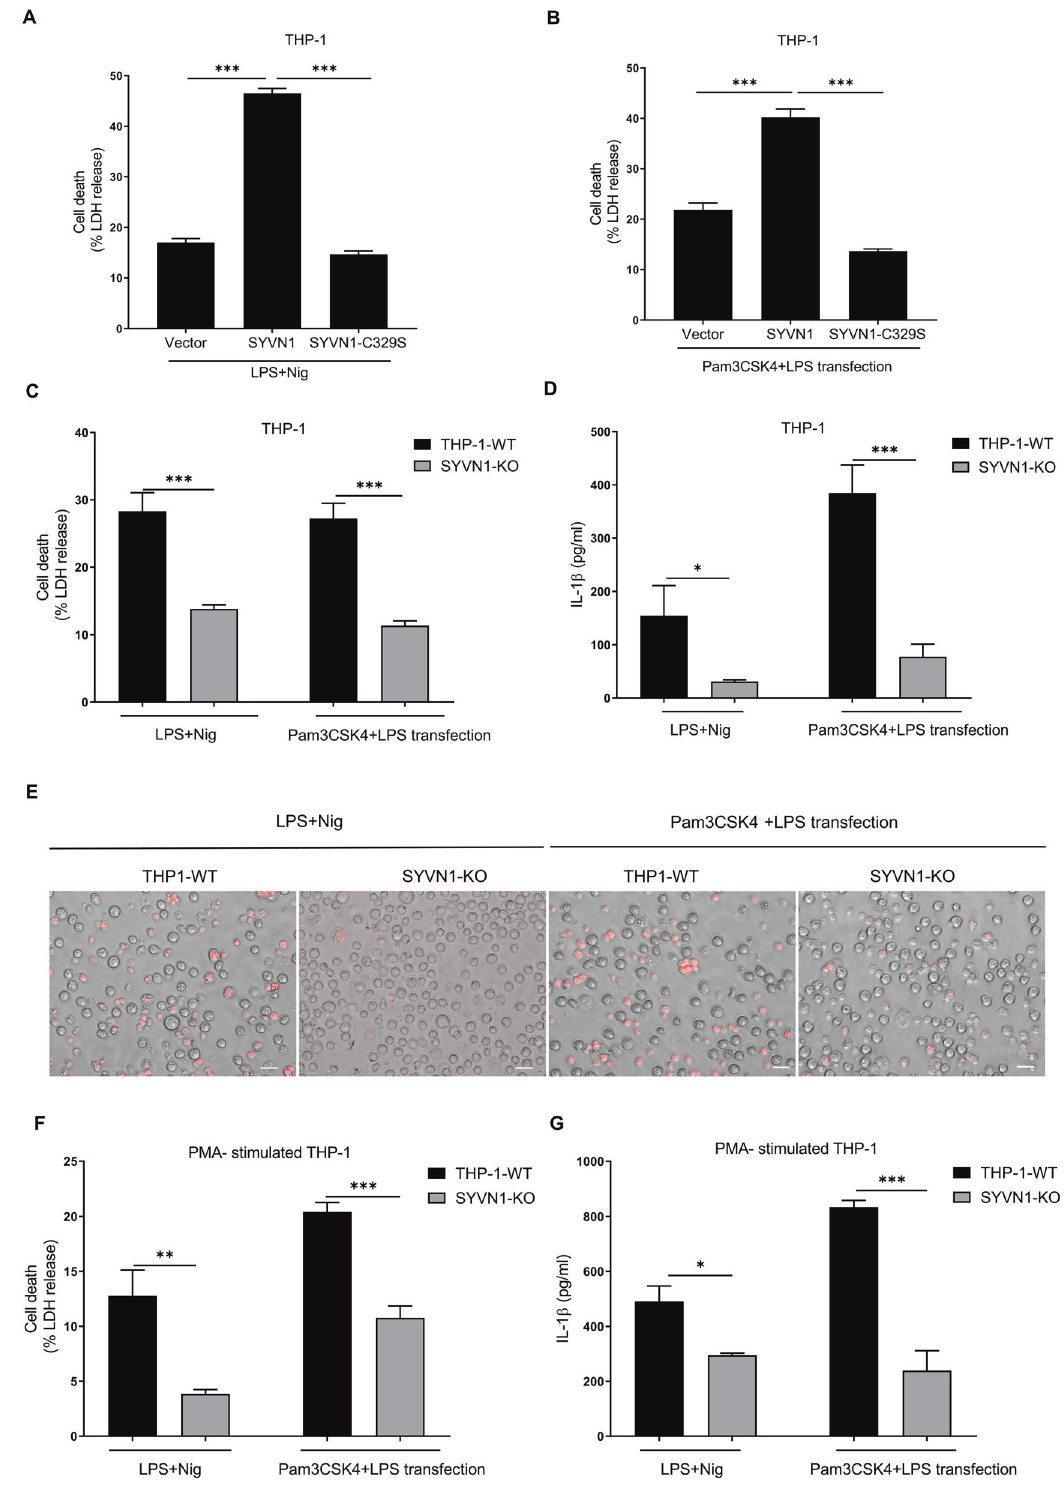
Fig. 5 Effect of inhibiting SYVN1 on pyroptosis in THP-1 cells. A THP-1 cells electrotransfected with SYVN1 or SYVN1-C329S for 24h were incubated with 500ng/mL LPS for 4h and then another 1h for 10 μ M Nigericin. The supernatants were collected and analyzed by LDH release assay. B THP-1 cells electrotransfected with SYVN1 or SYVN1-C329S were incubated with 500ng/mL Pam3CSK4 for 4h and then transfected with 2 μ g/ml LPS for 6h. The supernatants were collected and analyzed by LDH release assay. C – E THP-1 WT and SYVN1-KO cells were stimulated with LPS and Nigericin or stimulated with Pam3CSK4 and transfected with LPS the same way as above. The supernatants were collected and analyzed by LDH release assay ( C ) and ELISA for IL-1 β ( D ). The cells were observed by using PI staining ( E ). Scale: 1bar represents 20 μ m. F , G PMA-primed THP-1 WT, and SYVN1-KO cells were stimulated with LPS and Nigericin or stimulated with Pam3CSK4 and transfected with LPS the same way as above. The supernatants were collected and analyzed by LDH release assay ( F ) and ELISA for IL-1 β ( G ). Data were representative of three independent experiments. Cell Death and Disease (2022)